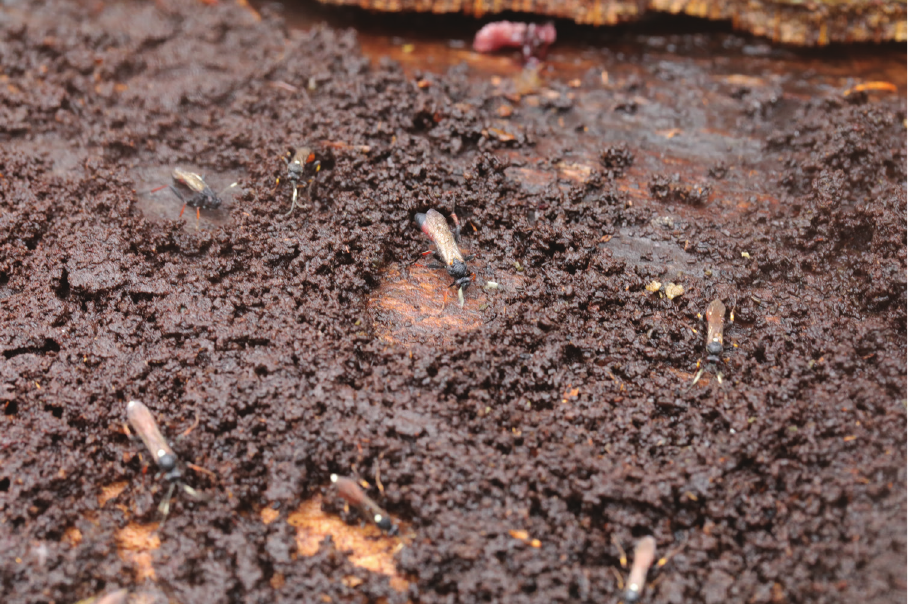
Figure 8. Impression of several Ichneumon spp. hibernating in a thick layer of bark humus, in this case Fagus sylvatica L. with a diameter of 80 cm; Belgium, Torhout (Bos van Wijnendale), 28 December 2021. Patrick